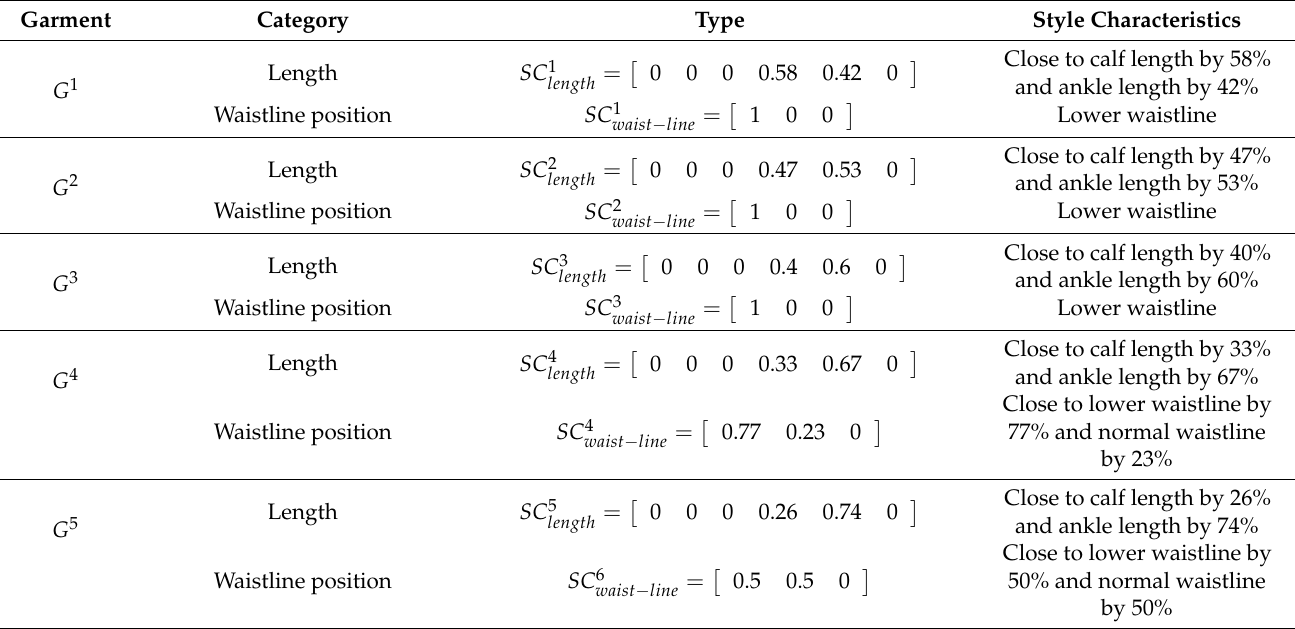
Table 3. The characteristics of the length and waistline